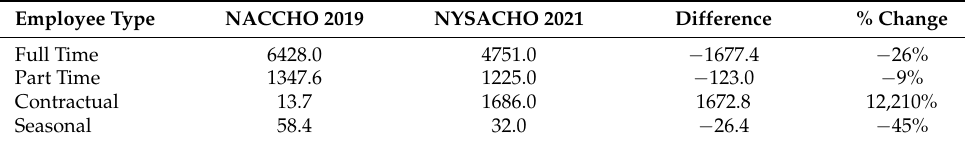
Table 4. Total FTEs Employed in LHDs (n = 15), by Employee Type, NYS (2019 vs. 2021).